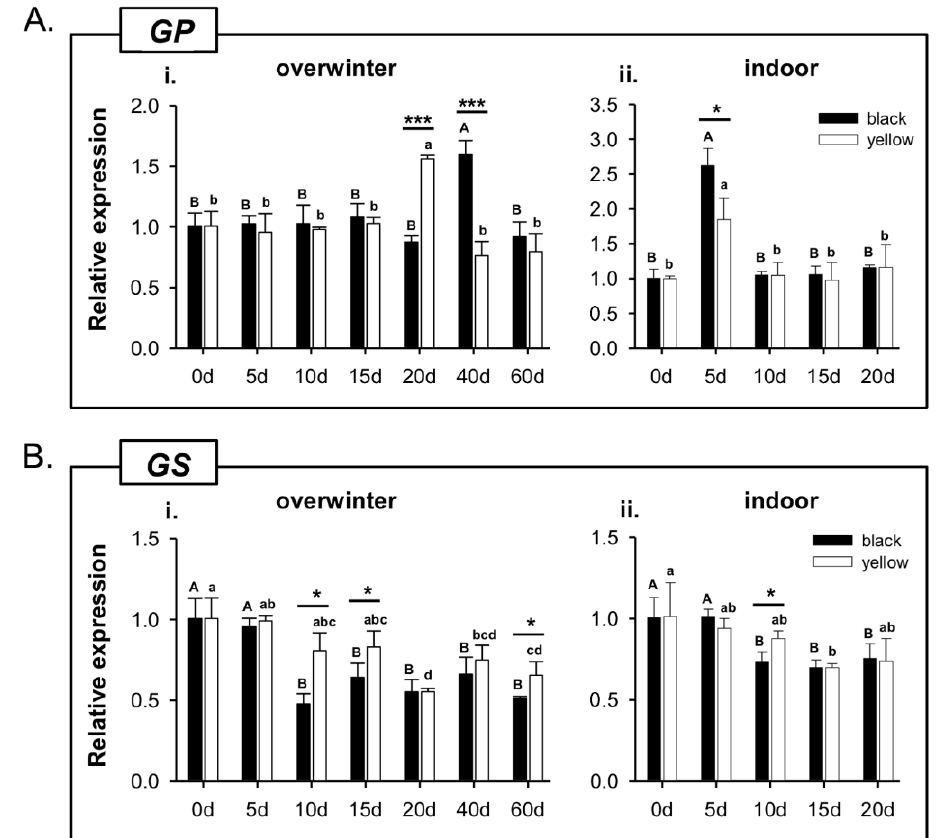
Figure 6. Changes in mRNA expression levels of GP ( A ) and GS ( B ) genes in H. axyridis yellow (non-melanic) and black (melanic) adults of the overwinter and experimental (indoor laboratory) populations under different cold storage periods (0 – 60 days and 0 – 20 days, respectively). The relative levels of the target genes were calculated based on the expression level of Harp49 ( H. axyridis ribosomal protein 49 gene) with RT-qPCR. Bars represent the mean (+SD) of three replicates. The expression level of each gene at 0 d of cold storage was used as the control group. Bars with different letters indicate significant differences (one-way ANOVA, p < 0.05). Asterisks indicate significant differences between yellow and black adults in the same storage period ( t -test, *** p ≤ 0.001; * p ≤ 0.05).